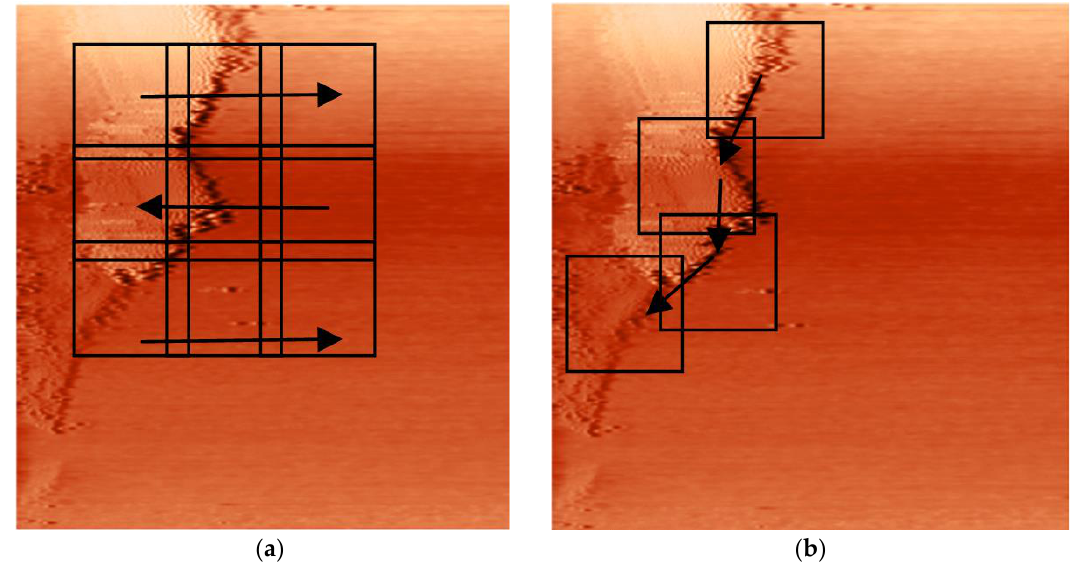
Figure 1. Options of the SPM operation in the process of the size monitoring: ( a ) uniform scanning; ( b ) tracking scanning.